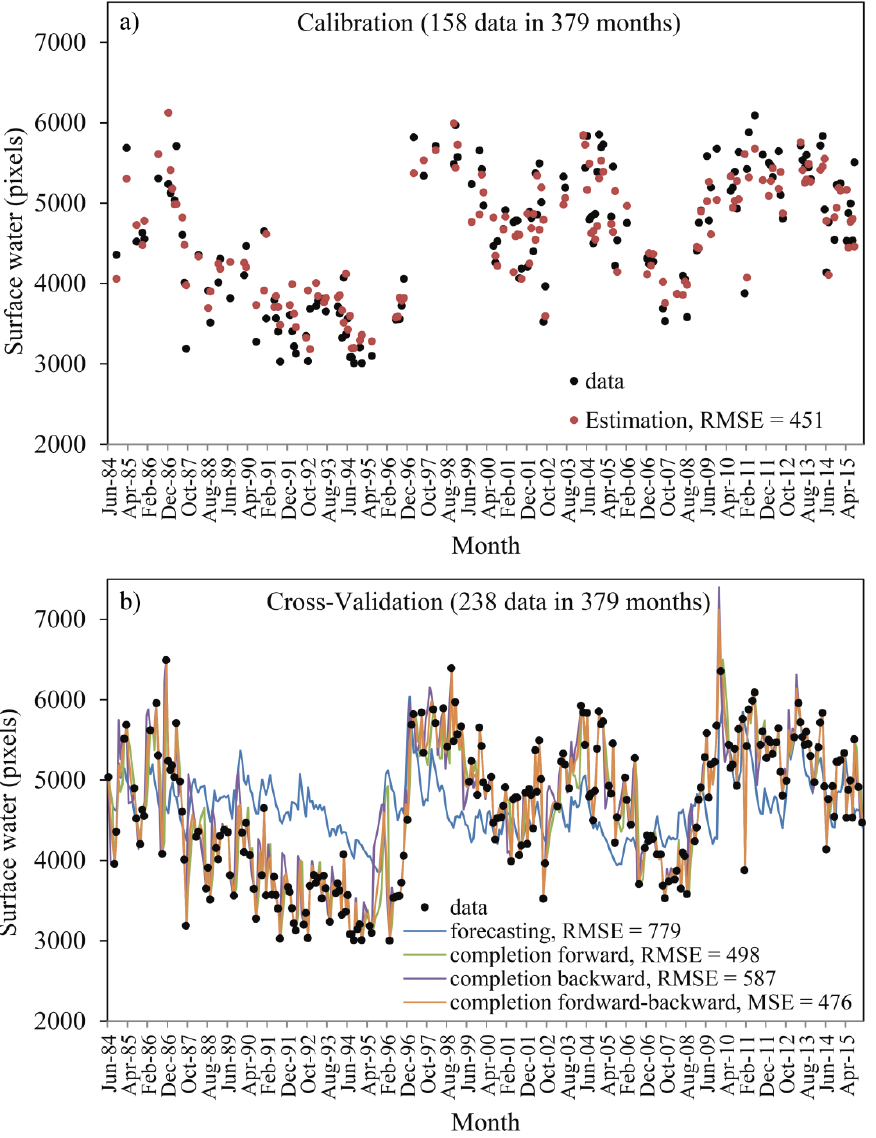
Figure 11 . Obtained root mean squared error (RMSE) for the ensemble of regression models: ( a ) calibration; ( b ) cross-validation.